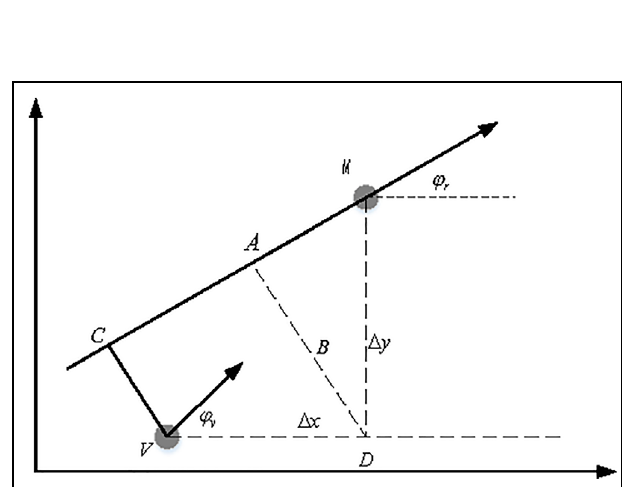
FIGURE 8 | Calculation of lateral and heading